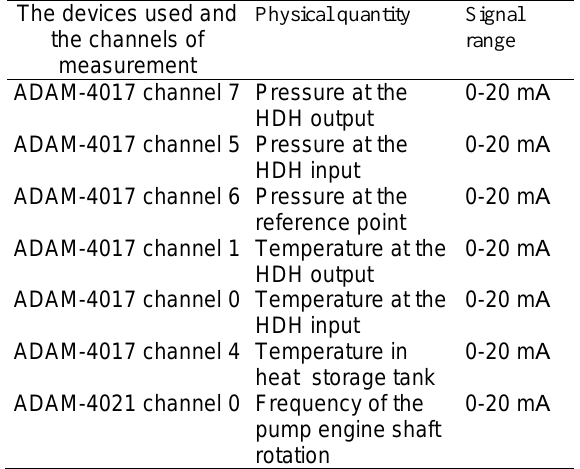
Table 4. The AFAM series devices and physical quantities measured